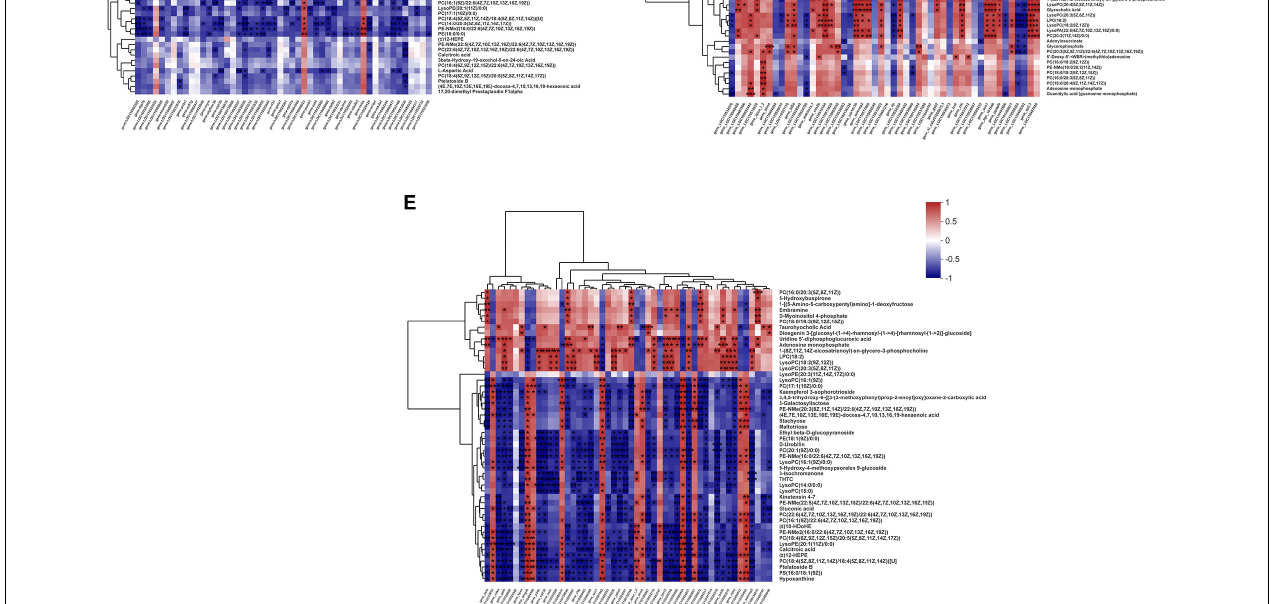
and anti-nutritional factors repress the growth performance of fish (Li et al., 2014). Additionally, fish feeding diets with reduction of dietary FM and FO appeared to have similar protein